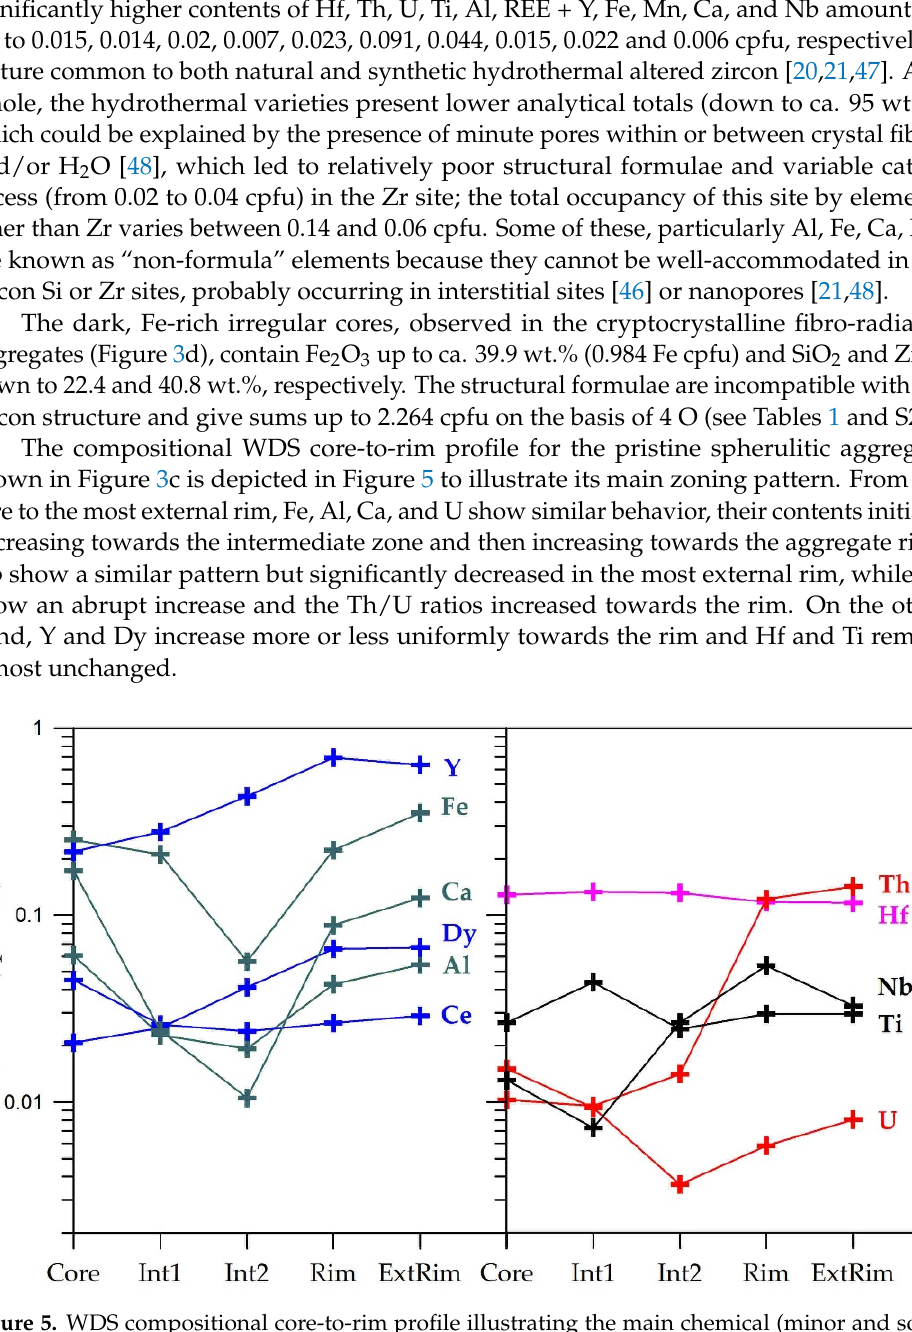
Figure 5. WDS compositional core-to-rim profile illustrating the main chemical (minor and some trace elements) variations, expressed in cations per formula unit (cpfu), of the spherulitic zircon aggregate shown in Figure 3f.